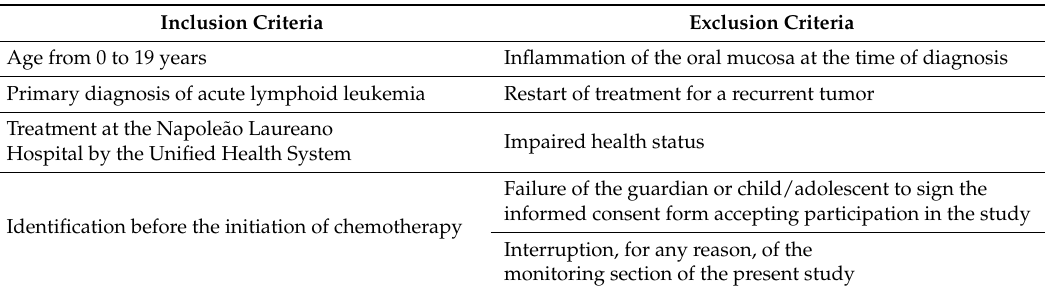
Table 1. Inclusion and exclusion criteria related to the recruitment of subjects for the present research